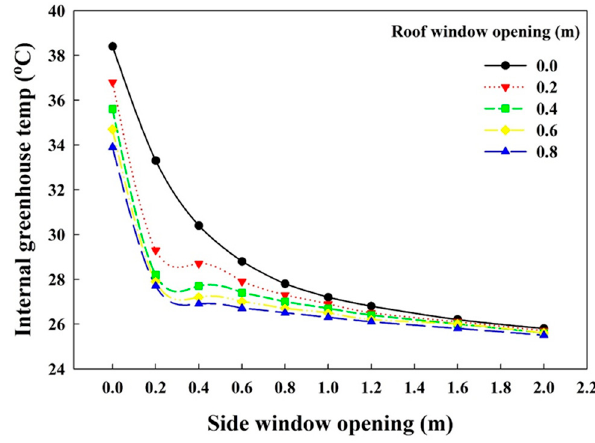
Figure 14. Variations in greenhouse internal temperature with different side and roof openings.